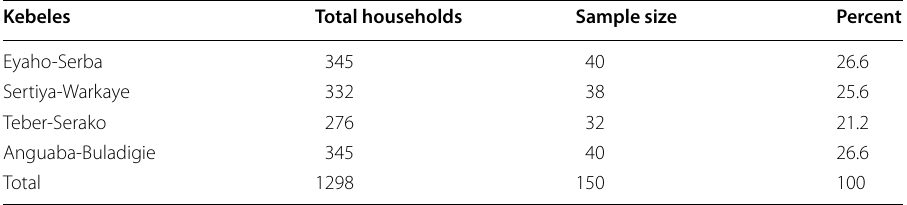
Table 1 Potato growing farmers and sample size. Source: Chilga District Agricultural office,